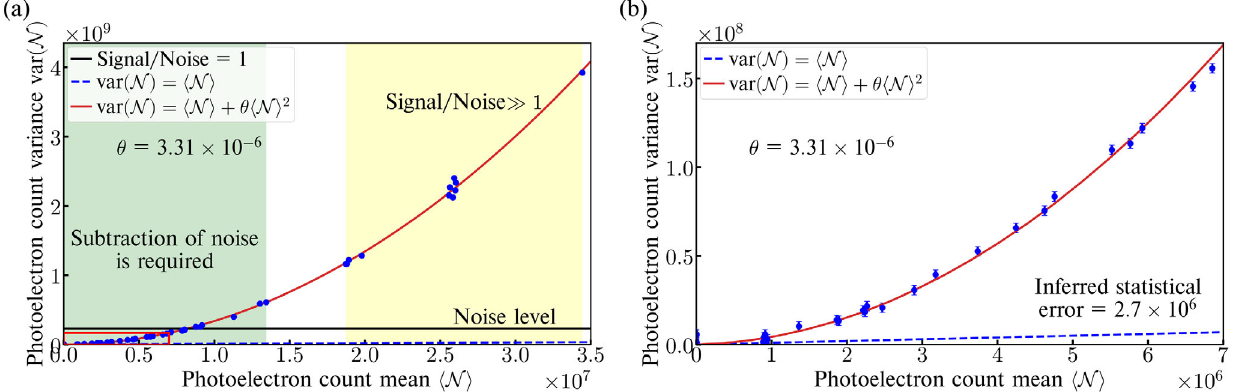
FIG. 7. Photoelectron count variance var ð N Þ as a function of photoelectron count mean h N i for the test light source; h N i was varied by using different neutral density filters. (a) The entire range of h N i , var ð N Þ . (b) The region corresponding to the values of var ð N Þ generated by the undulator radiation in IOTA [highlighted by the red rectangle in